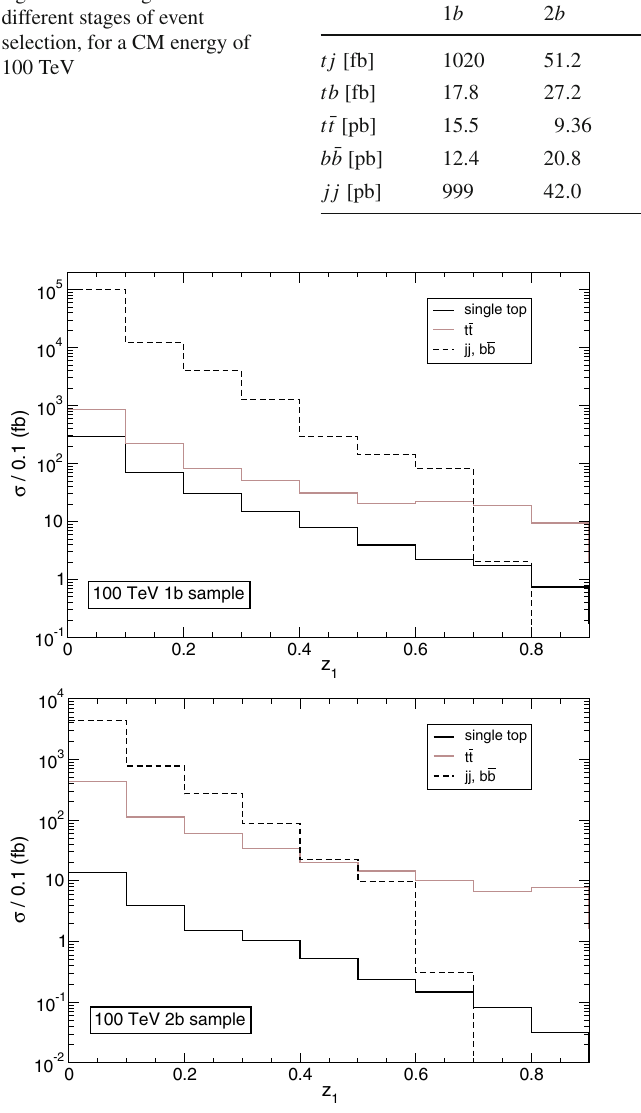
Fig. 7 Signalandbackground crosssectionsasafunctionofthelepton momentum fraction z 1 after the final selection in the 1 b (top) and 2 b (bottom) samples, for a CM energy of 100 TeV